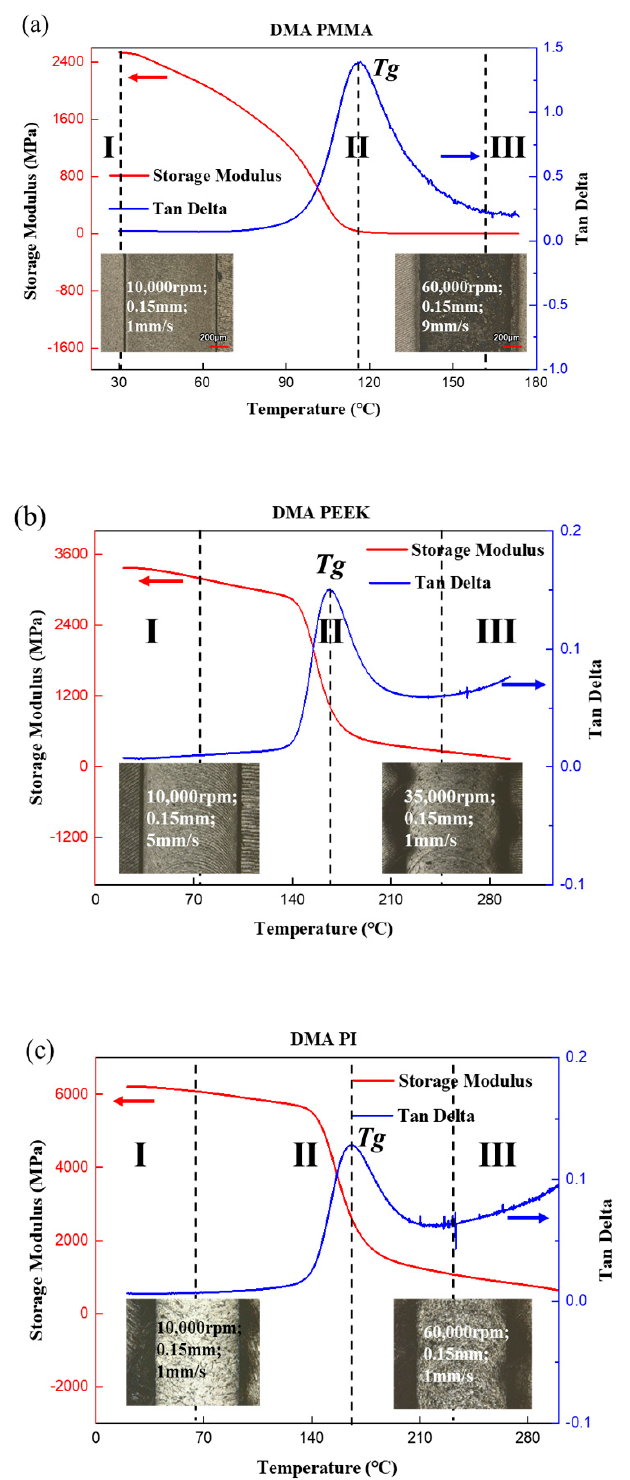
Figure 3. Dynamic properties (loss factor (tan( δ )) and storage modulus (E ′ ), three distinct regimes: (I) glass state (II) viscoelastic (III) rubbery) vary with temperature, ( a ) dynamic mechanical analysis (DMA) of PMMA, ( b ) DMA of PEEK, ( c ) DMA of PI. According to the results, the Tg for three kinds of PMMA, PEEK, and PI are 116 ◦ C, 167 ◦ C, and 166 ◦ C, respectively. Three distinct regimes, such as the glassy regime, vis- coelastic regime, and the rubbery regime, could be found, and different groove